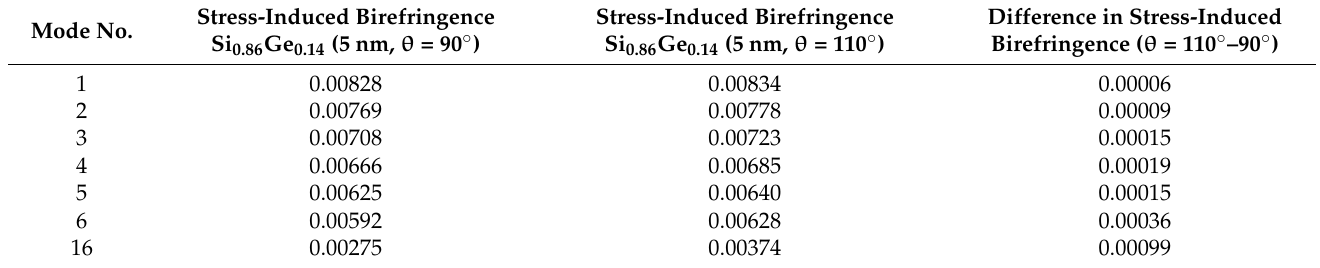
Table 1. Stress-induced birefringence experienced by the different modes at 20 ◦ C.